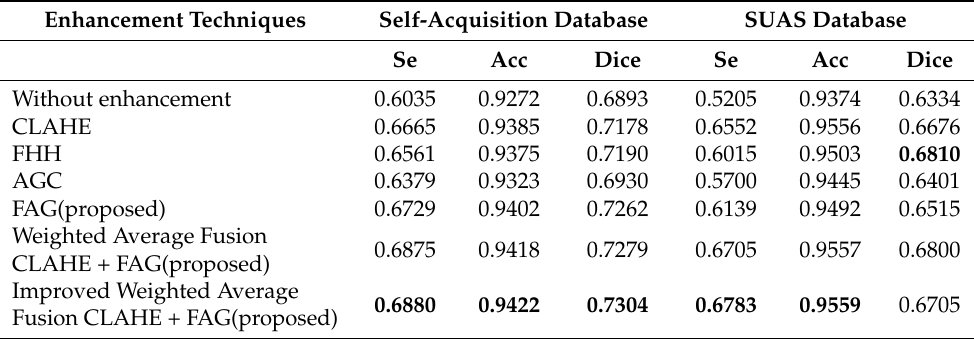
Table 2. Average results of vein segmentation using various techniques of enhanced images on two databases. The best values are indicated in